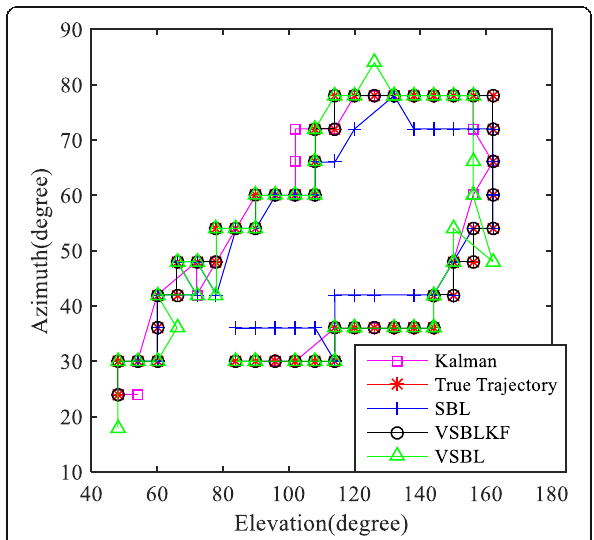
Fig. 4 Traces of four methods based in the on-grid model